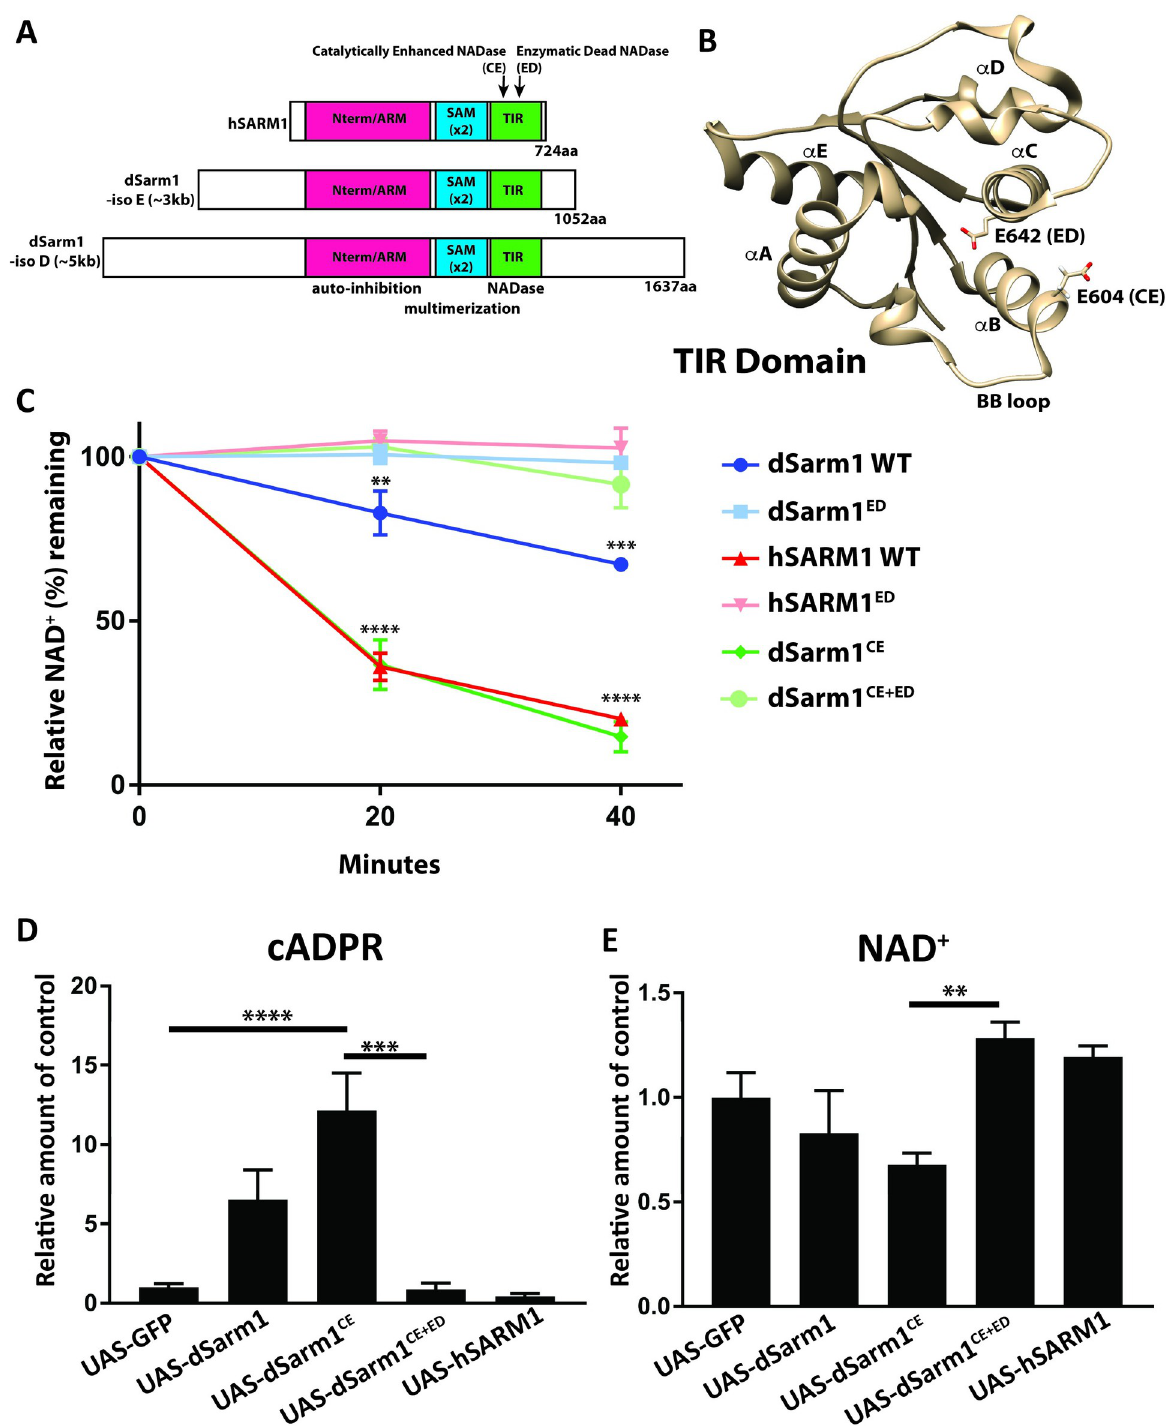
Fig 1. Identification of gain and loss of function mutations in the TIR domain of dSarm1. A, Schematic of the major domains and location of the point mutations that confer either catalytically enhanced or enzymatic dead NADase activity on dSarm1. Human SARM1 and isoforms E (3kb) and D (5kb) of Drosophila Sarm1 are depicted B, Crystal structure of the TIR domain from human SARM1 is depicted (PDB structure 6O0Q; from [24]) with mutant residues depicted. C, NADase activity assay. One hundred nanograms of TIR proteins purified from HEK cells were incubated with NAD + for indicated times. NAD + metabolites were quantified by HPLC and percent of NAD + remaining is shown. Values are presented as mean +/- SEM. Statistics were obtained by performing a one-way ANOVA with Tukey’s multiple comparisons for genotypes.